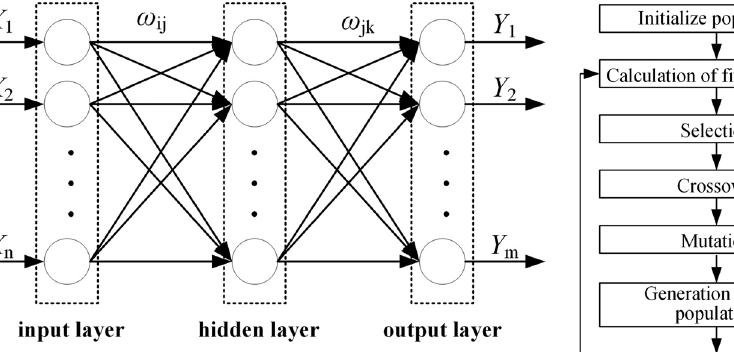
Figure 2: Structure of BP neural network.